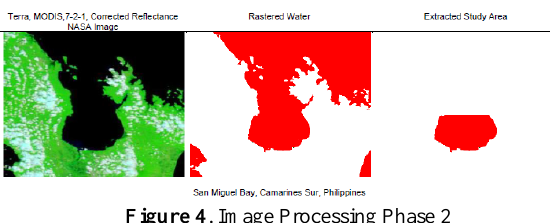
Figure 3 . Chesapeake Bay Train Images